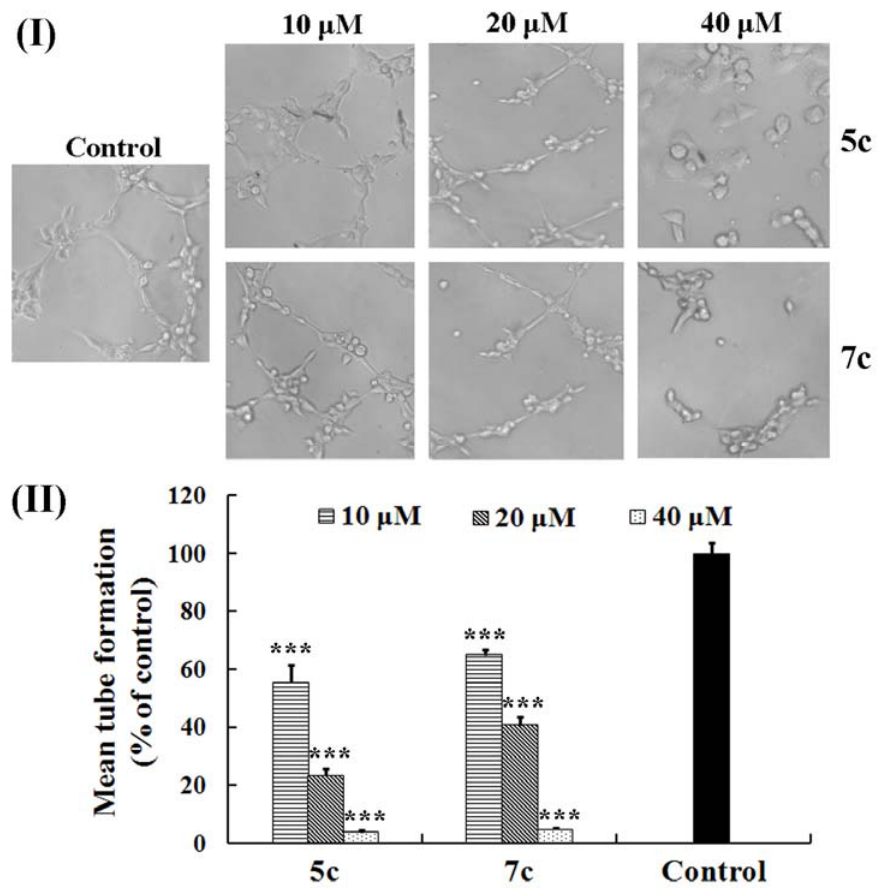
Figure 2. Effects of 5c and 7c on the HUVECs Tube Formation. ( I ) HUVECs (1 × 10 4 cells) suspended in DMEM containing the tested compound (10, 20, and 40 μ M) were added to the Matrigel. Control was treated with DMEM alone. After incubation for 24 hours at 37 °C, capillary networks were photographed and quantified (magnification: 200×). ( II ) The number of mean tube formation was counted in five randomly chosen regions and expressed as the percentage of the control. The results were expressed as mean ±